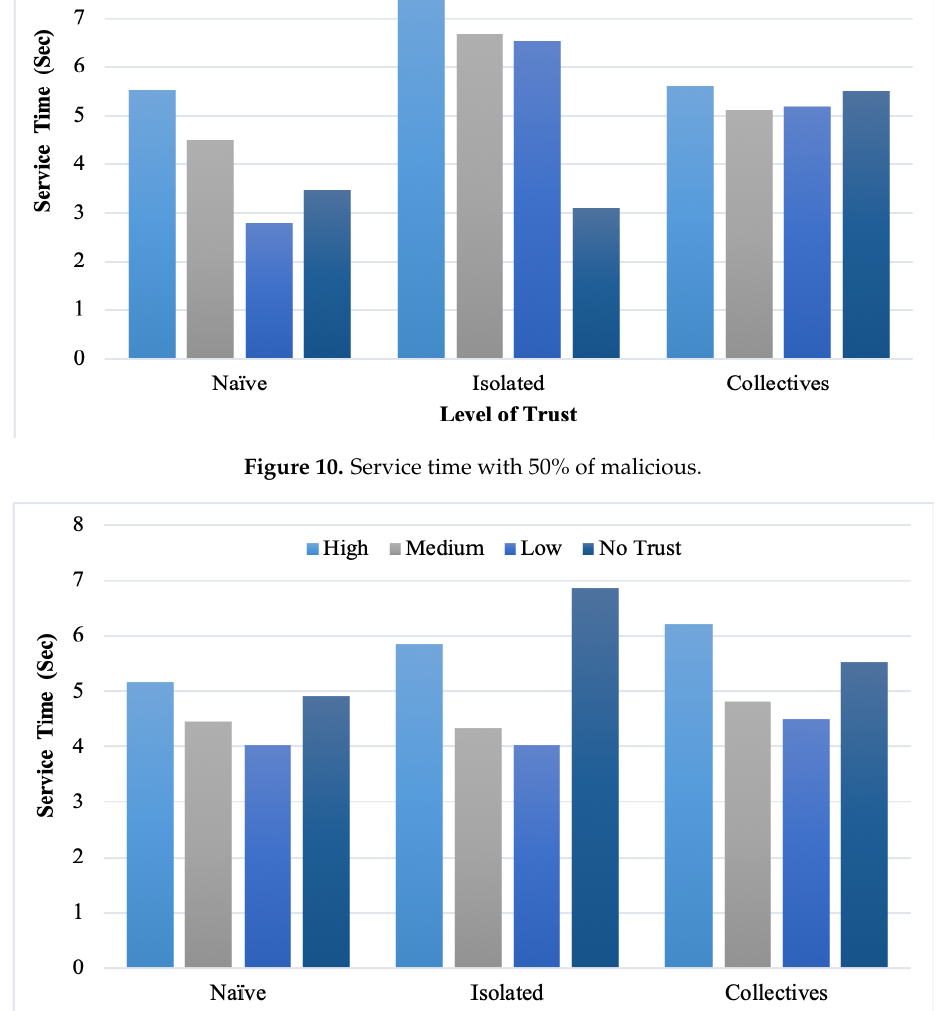
Figure 11. Service time with 30% of